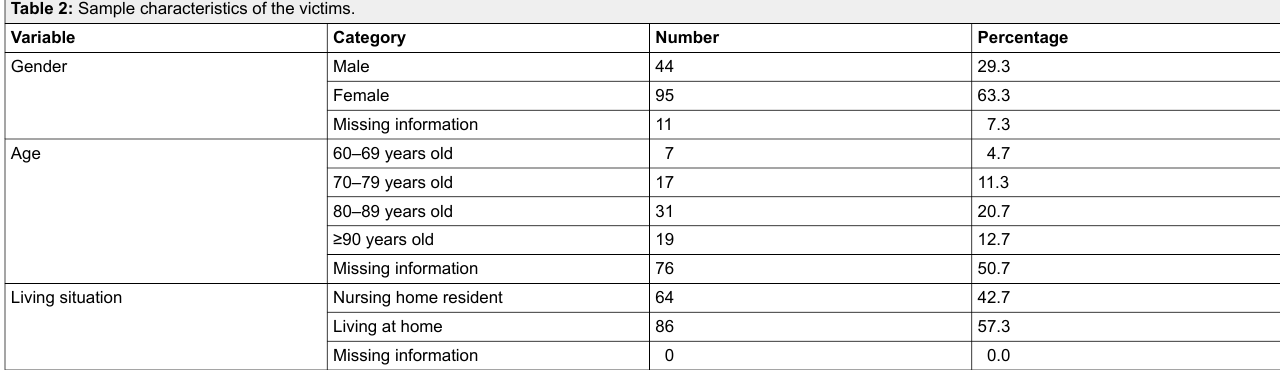
Table 2: Sample characteristics of the victims.